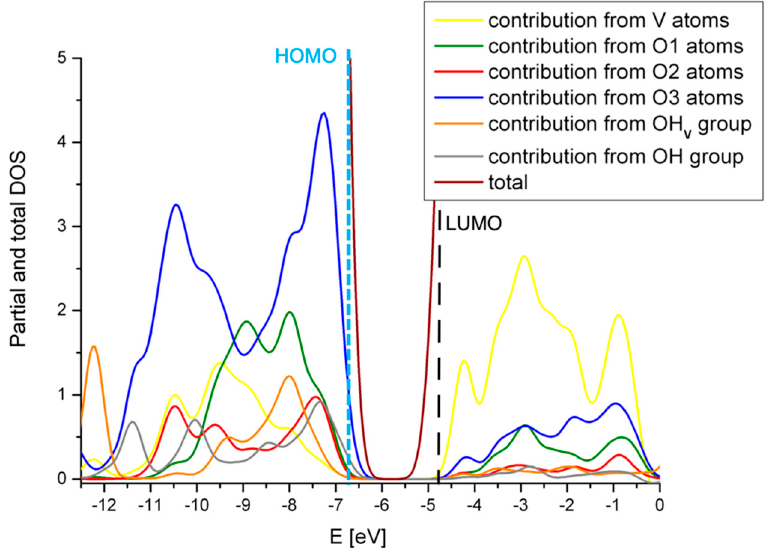
Figure 14. DOS plot of the V 20 O 63 H 26 cluster.